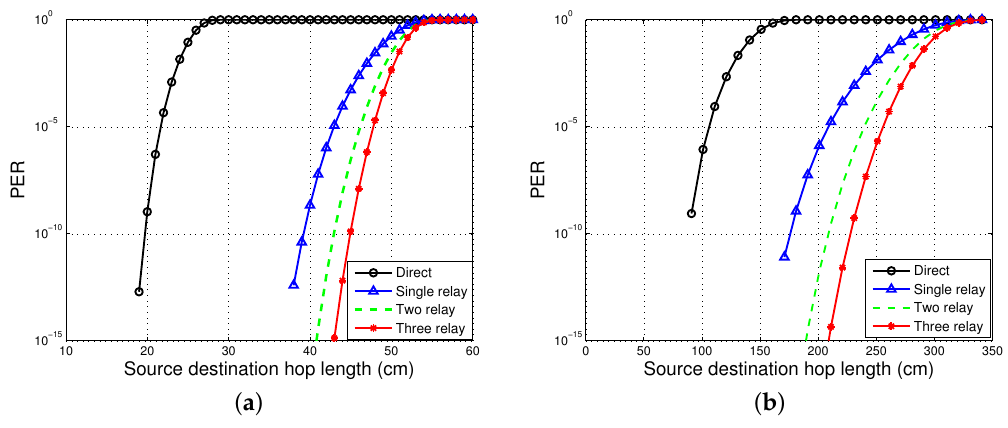
Figure 2. Packet error rate (PER) analysis. ( a ) PER for on-body NLOS communication; ( b ) PER for on-body LOS communication.